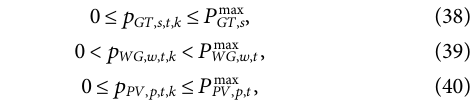
FIGURE 4 Process of the proposed solution